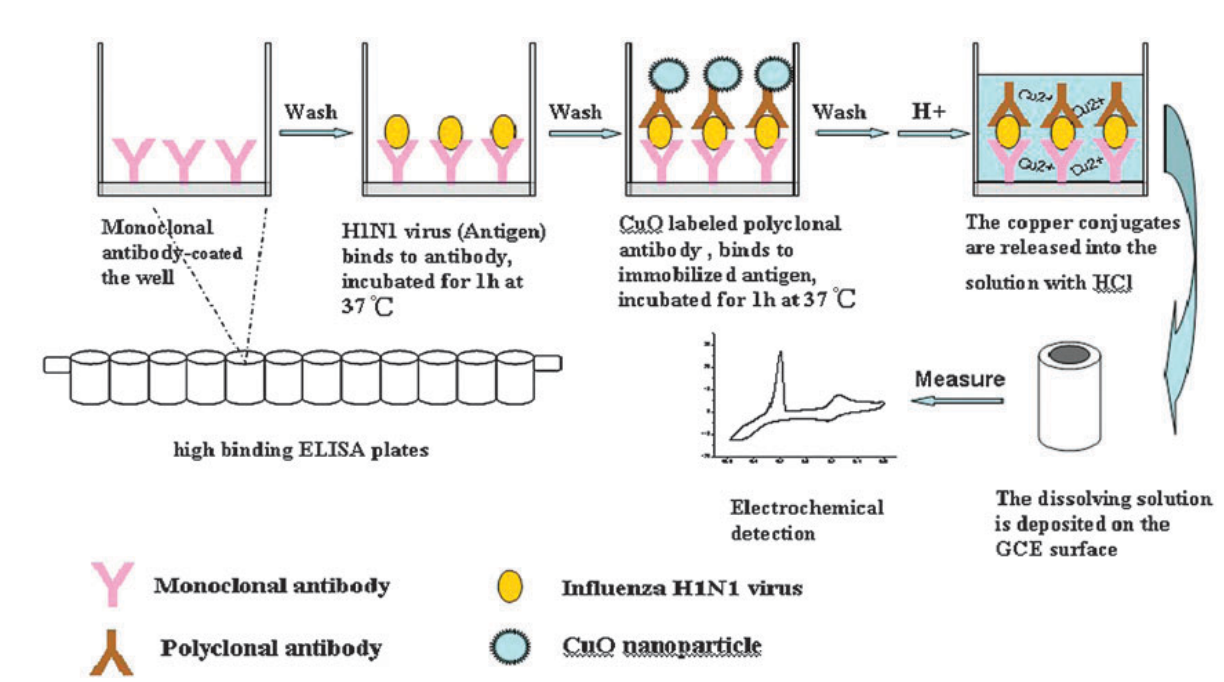
Figure 20. Sandwich-type immunoassay based on CuO-labeled antibody and electrochemical analysis [63].